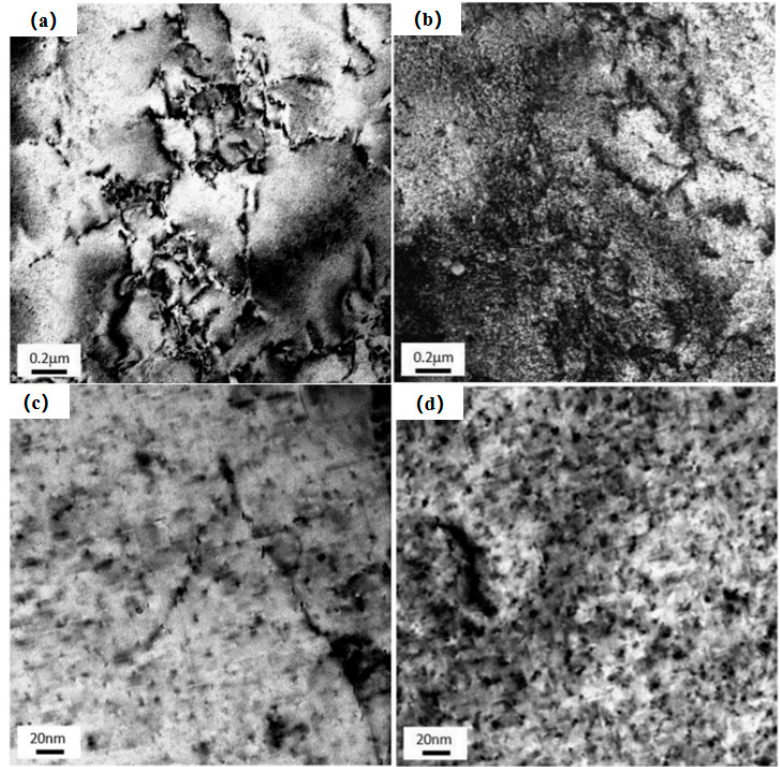
Figure 6. TEM bright field images of microstructures observed in the <100> Al zone axis orientation after artificial aging with and without pre-strain. ( a ) As-quenched sample with pre-strain (10%); ( b ) Under-aged sample with pre-strain (10%); ( c ) Under-aged sample with pre-strain (180 °C); ( d ) Peak- aged sample with pre-strain (180 °C) [33].